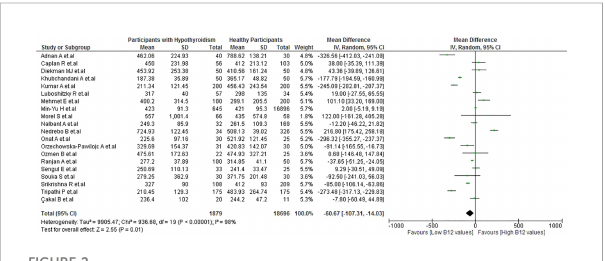
FIGURE 2 Vitamin B12 values in patients with hypothyroidism vs healthy patients.